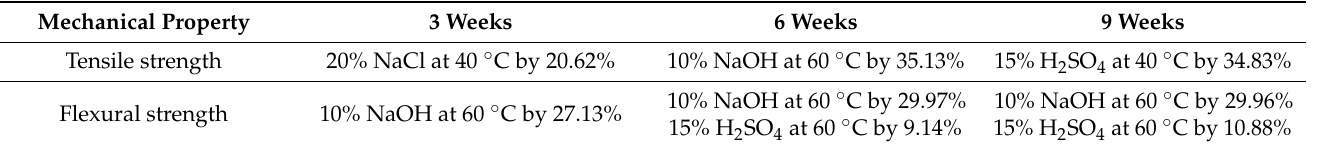
Table 6. Decrease in the tensile strength and flexural strength of the CFRP